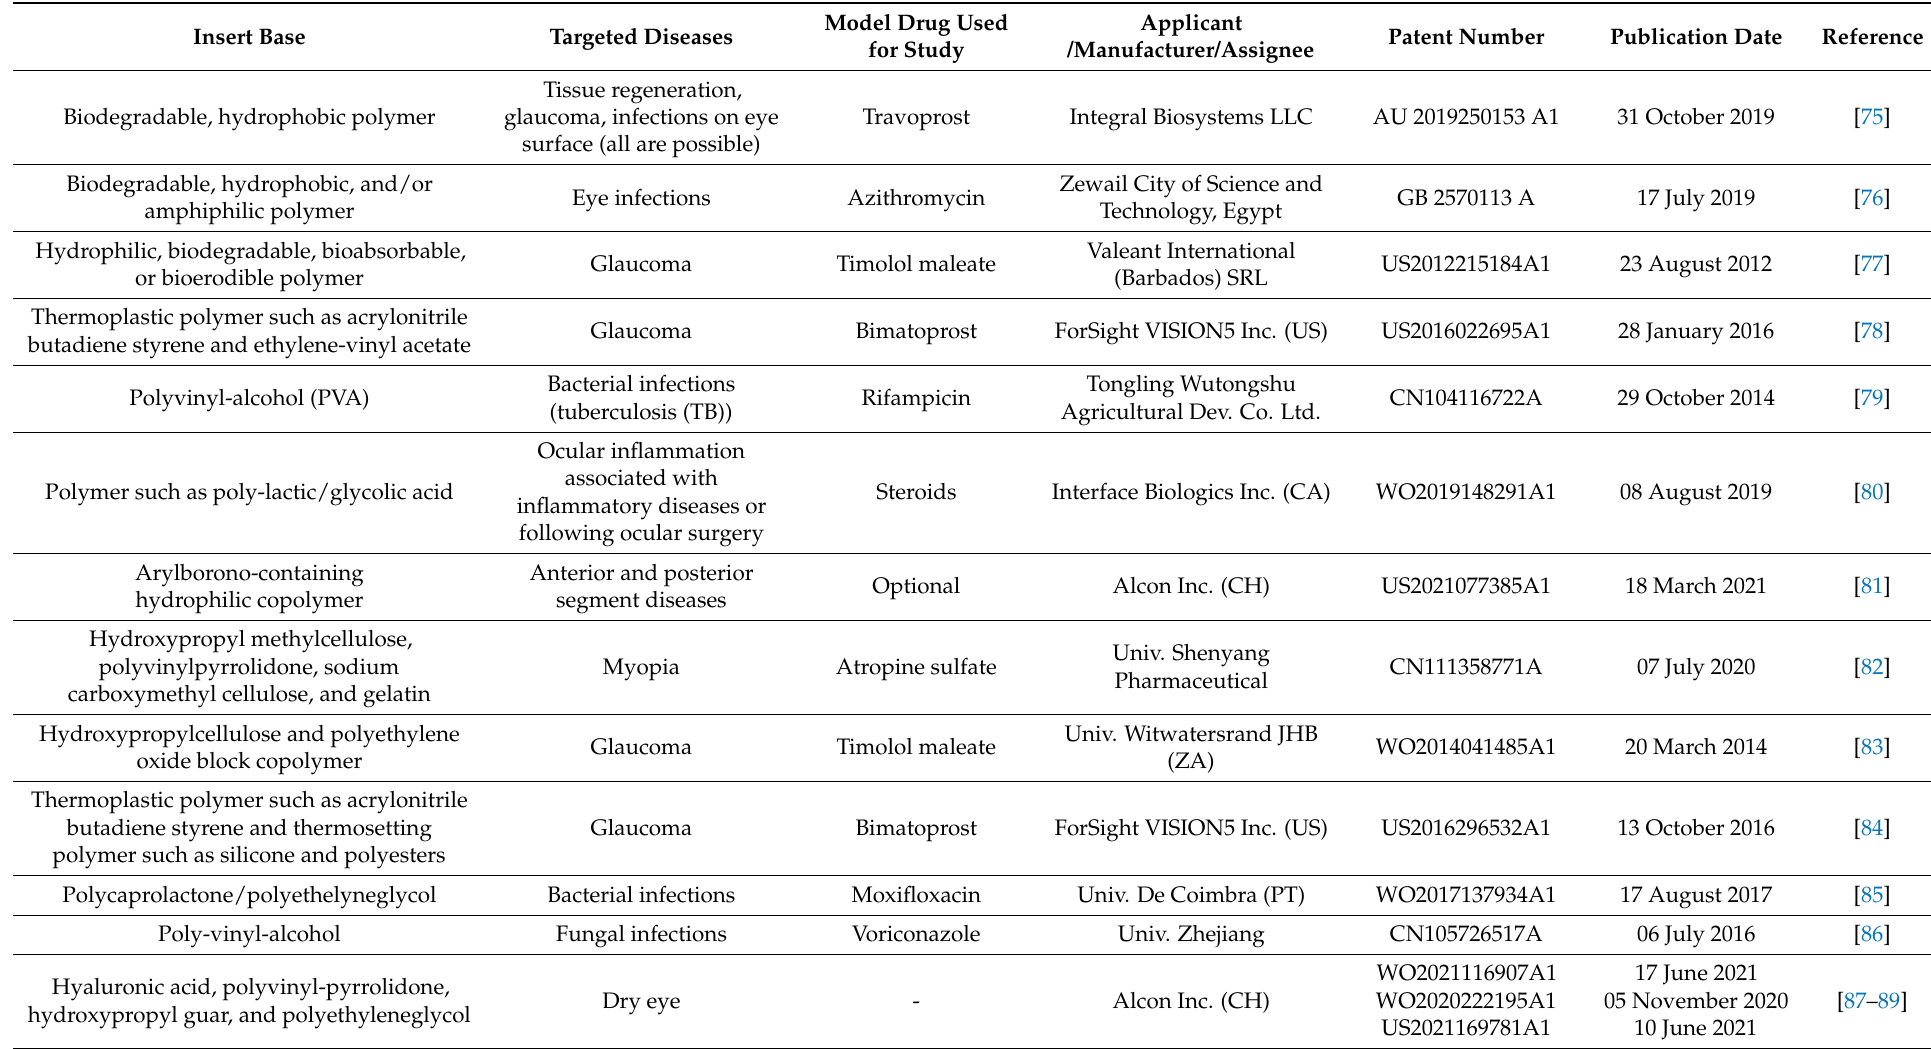
Table 3. Summary of ocular insert patents studies